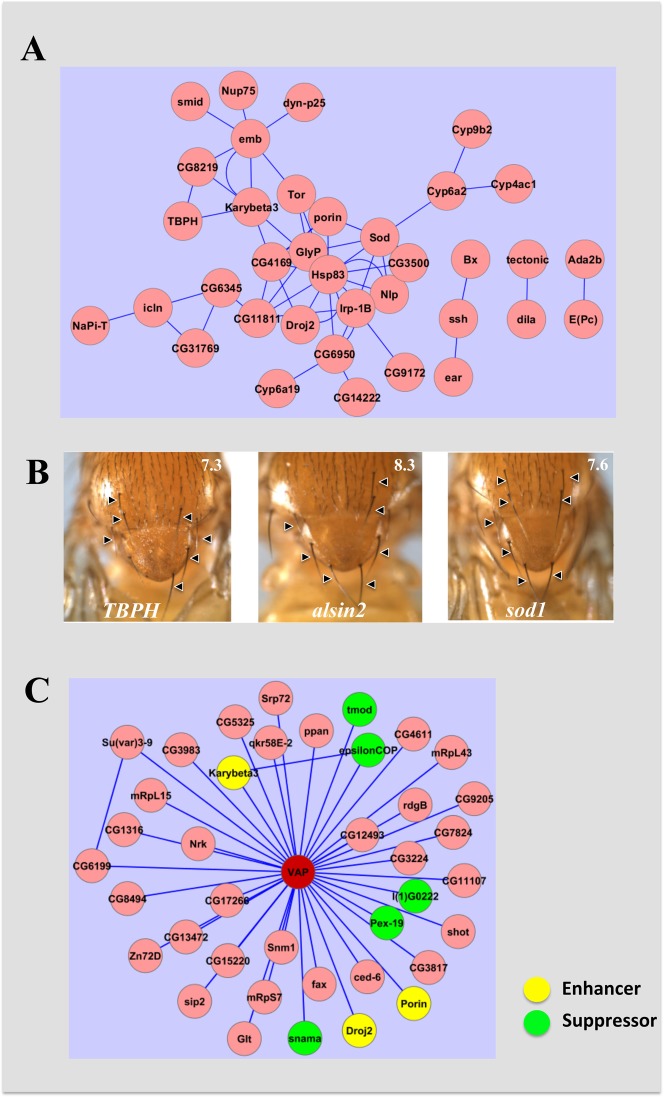
An integrated network of dVAP genetic interactors.An extended network of dVAP network was built by integrating VAP interaction data from our screen (103 genes) with known physical interactors of dVAP. The extended network (not shown) includes 406 genes and 953 edges. (A) Analysis indicated that 36 modifiers (displayed as circles), which are a subset of the 103 modifiers discovered, interact physically among themselves. Blue connecting lines (edges) indicate physical interaction. (B) Drosophila homologs of known ALS causing loci, TBPH, Alsin and sod1 are suppressors of dVAP function and are part of the genetic network. The genotype for each cross is Sca-Gal4/+; UAS-VAP/UAS-Gene-RNAi. For each figure, average macro chaetae values from ten females are represented on the top right hand corner. (C) Thirty-five known physical interactors of VAP are a subset of the 2635 genes screened in this study. Of these, eight genes were found to be genetic interactors of VAP. SNAMA, tmod, lethal (1) G0222, epsilon-COP and Pex-19 are suppressors while Droj2, karyopherin beta3, Porin are enhancers.